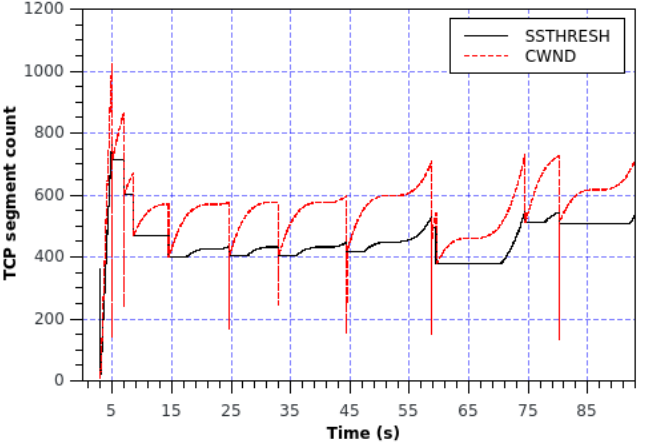
Figure 19. Slow start threshold and congestion window on TCP sender with a modified Linux